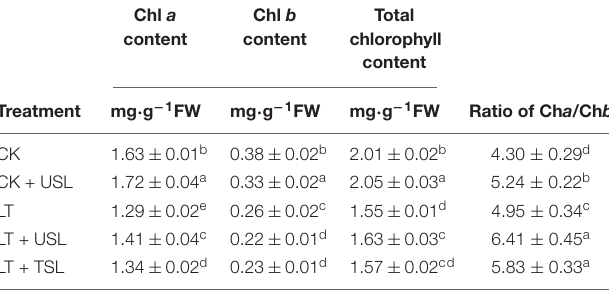
TABLE 2 | Effects of USL on the leaf chlorophyll content of tomato seedlings under LT